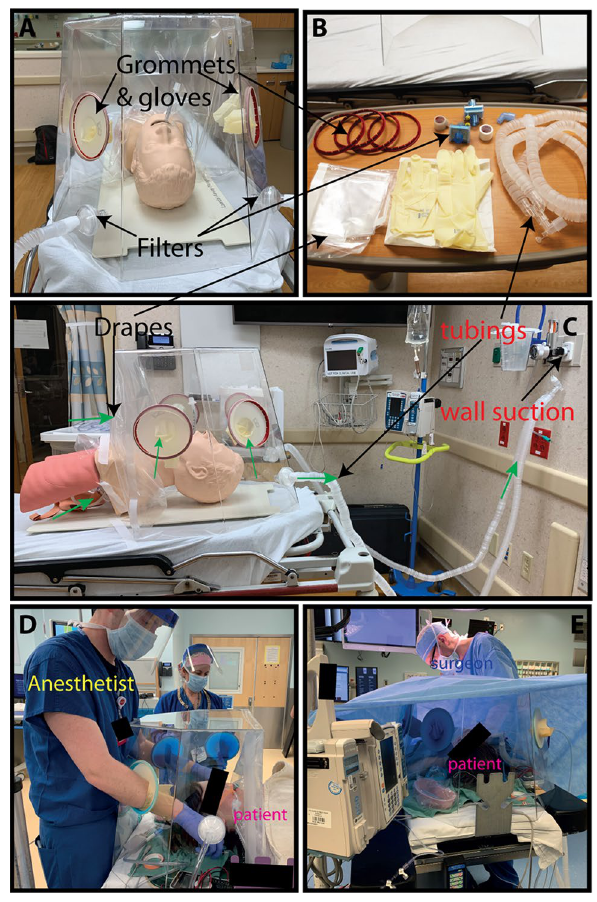
Figure 3. BADGER’s setup and its use in operating room. ( a – c ) Setup of the BADGER on a mannequin. The BADGER uses commonly available hospital supplies to create isolation and semi-sealed chamber. Accessories for each BADGER are: two viral HEPA filters, two 60 cm × 60 cm clear drapes, 5–10 m of 6 mm or 7 mm inner diameter tubing, one dual-limb breathing circuit tubing, 2 pairs of size 8.5 or 9 surgical gloves. Grommets and surgical gloves are assembled into sleeve-rings to seal the hand-ports. Drapes are taped to create overlapping opening for the torso/neck. Direction of airflow into and out of the BADGER are depicted as green arrows ( c ). ( d , e) Clinical application of an earlier version of the BADGER on a patient for intubation ( d ) and intraoperative use ( e